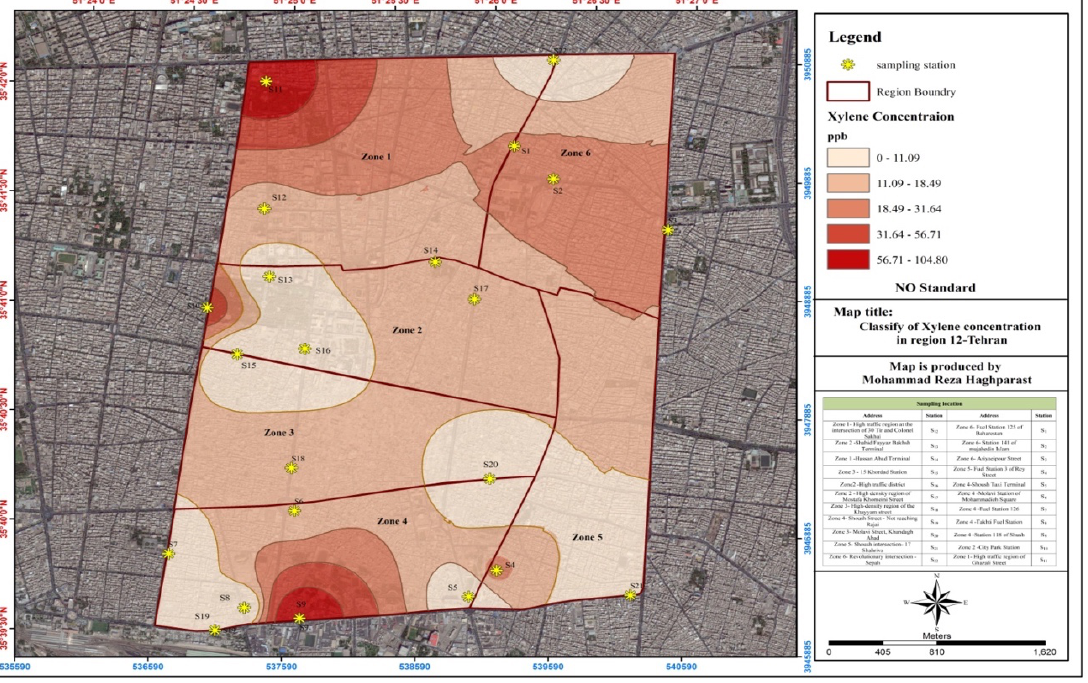
Figure 11. Zoning Xylene concentration in the region on January,